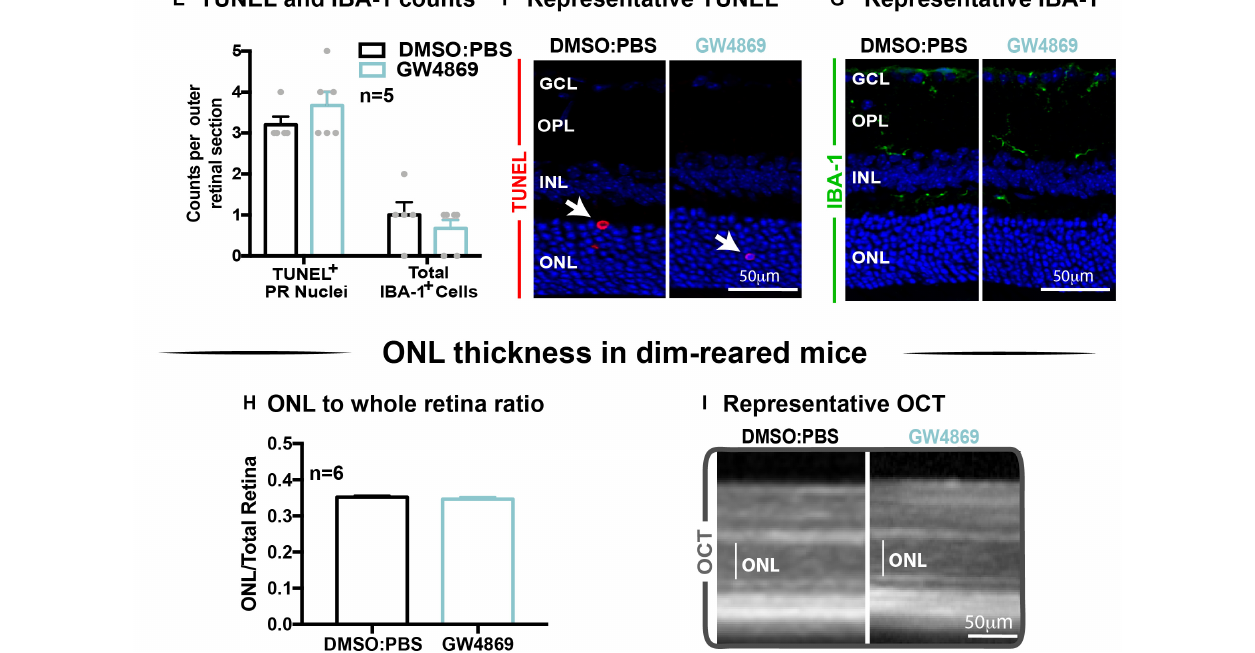
FIGURE 5 | Exosome inhibition via the use of GW4869 in dim-reared mice reduces retinal function. (A) Experimental paradigm. Following 5 daily intraperitoneal injections of GW4869 (1.25 mg/kg), retinal ERG function, (B) shown in representative ERG traces, was significantly reduced for both (C) a-wave and (D) b-wave responses, compared to DMSO controls in DR mice ( P < 0.05, n = 6). (E) No significant changes were seen in either the number of TUNEL + cells in the outer nuclear layer, or in the number of IBA-1 + cells in the outer retina following 5 daily intraperitoneal injections of GW4869 compared to DMSO controls ( P > 0.05, n = 5). Representative confocal images show (F) TUNEL + cells (white arrows) and (G) IBA-1 + cells in the outer retina, in both GW4869 and DMSO injected DR mice. Representative confocal images are taken in the superior outer retina, 1 mm from optic nerve head. (H) There was no change in ONL thickness (represented as ratio to total retinal thickness), as measured by ocular coherence tomography (OCT) between GW4869 or DMSO injected DR mice ( P > 0.05, n = 6). (I) Representative images of OCT scans show ONL thickness in superior retina, (white line) in GW4869 and DMSO injected DR mice. Scale bars = 50 µ M. * denotes = P < 0.05.